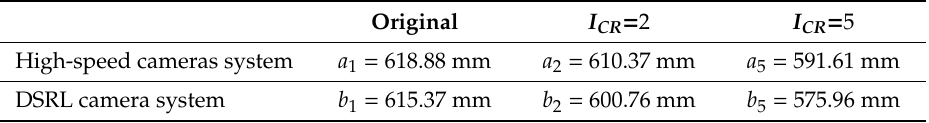
Table 10. Summary of the peak displacement value as measured from original and compressed images from both monitoring